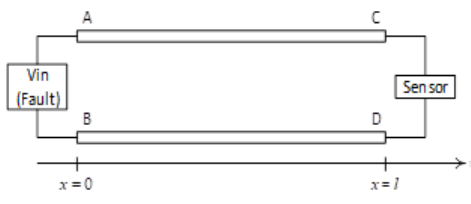
Figure 24. Schematic of the fault